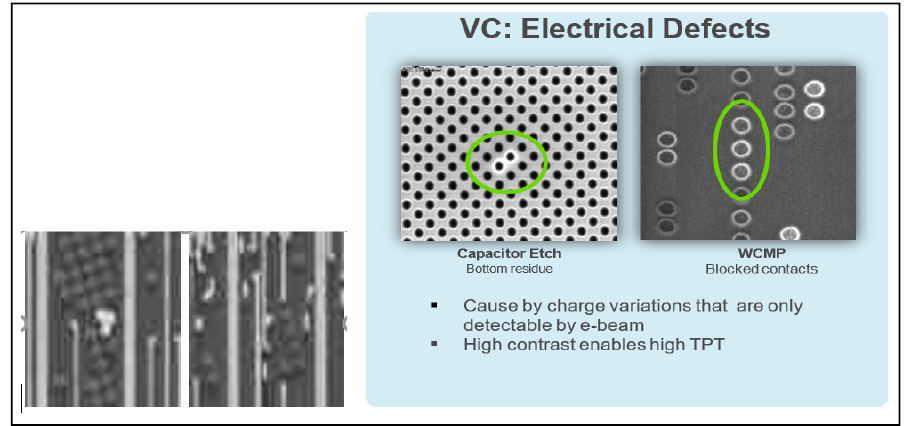
Figure 9. Voltage contrast electrical defects caused by charged variations are detectable by e-beam.